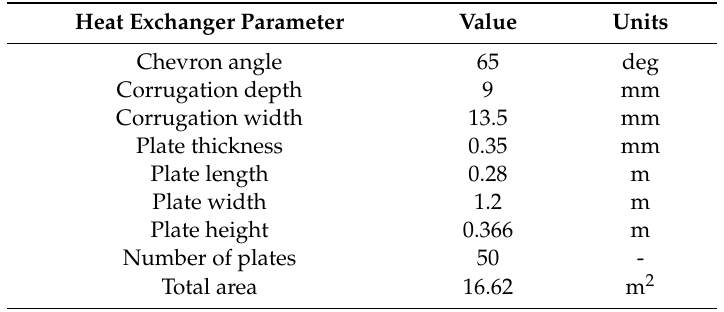
Table 7. Geometrical dimensions of the plate heat exchanger of the LT loop